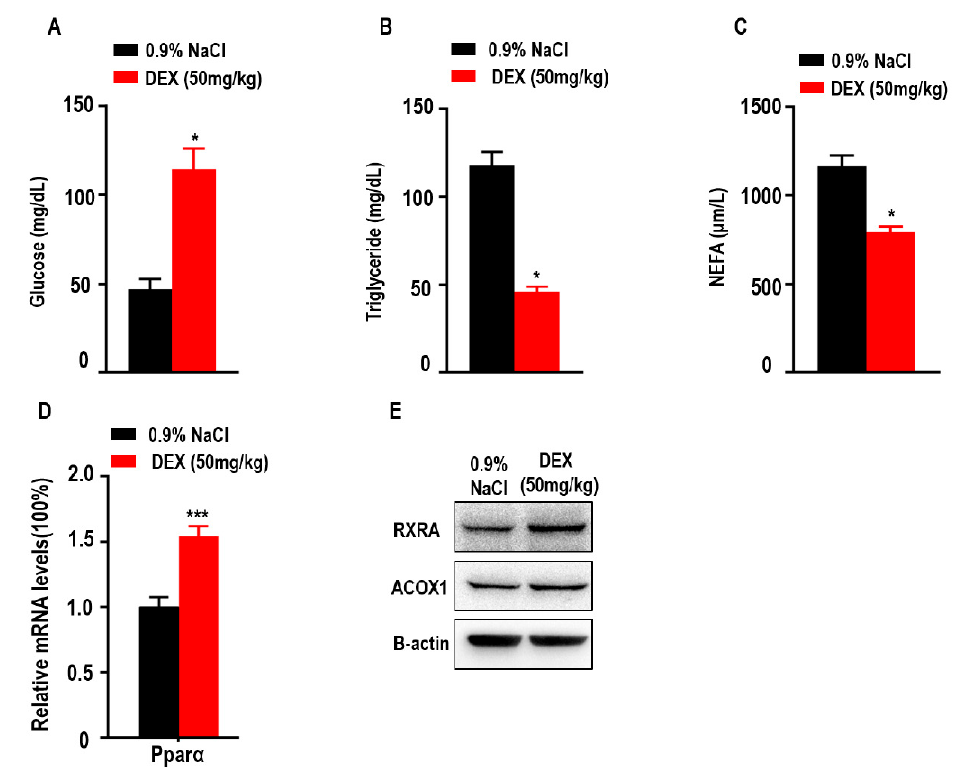
Figure 5. Treatment with high-dose DEX significantly reduced serum triglyceride and non-esterified fatty acid (NEFA) levels, and increased serum glucose levels in tumor-bearing mice. Quantification of serum glucose ( A ), triglycerides ( B ), and NEFAs ( C ) in tumor-bearing mice ( n = 3 mice per group) after treatment with 0.9% NaCl and 50 mg / kg DEX. ( D , E ) The expressions of proliferator-activated receptor α (Ppar α ), retinoid X receptor alpha (RXRA), and peroxisomal acyl-coenzyme A oxidase 1 (ACOX1) were determined via qPCR or Western blotting of livers taken from C57BL / 6 mice treated with 0.9% NaCl or 50 mg / kg DEX. All data are presented as mean ± SEM and p < 0.05 is considered significant (* p < 0.05, ** p < 0.01, *** p < 0.001; n = 3 mice per group). Results are representative of three independent experiments.